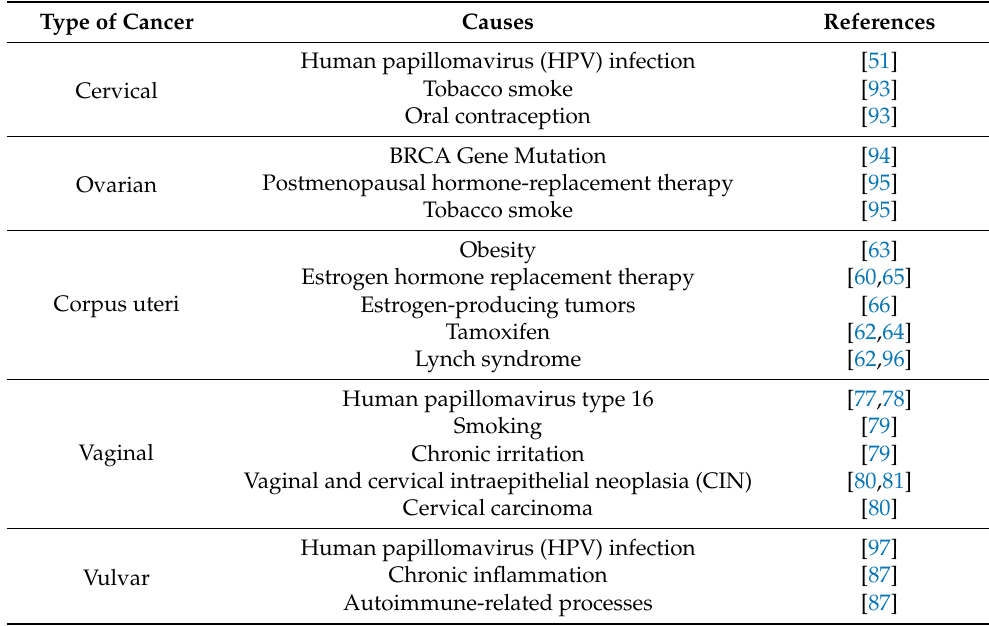
Table 1. The most common causes of the female reproductive system cancers. Type of